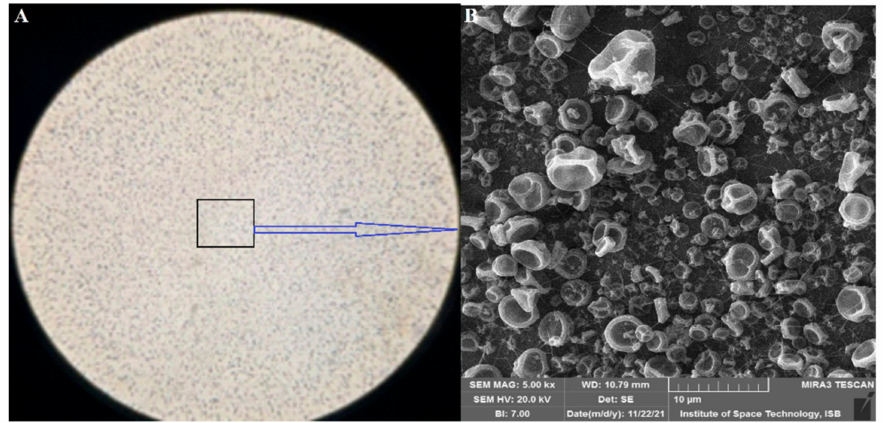
Figure 7. Picture of electrospun CA + HS 10% higher than 16 kV and a flow rate of 1 mL/h ( A ) electrospun substrate; ( B ) SEM image of electrospun splashing beads.